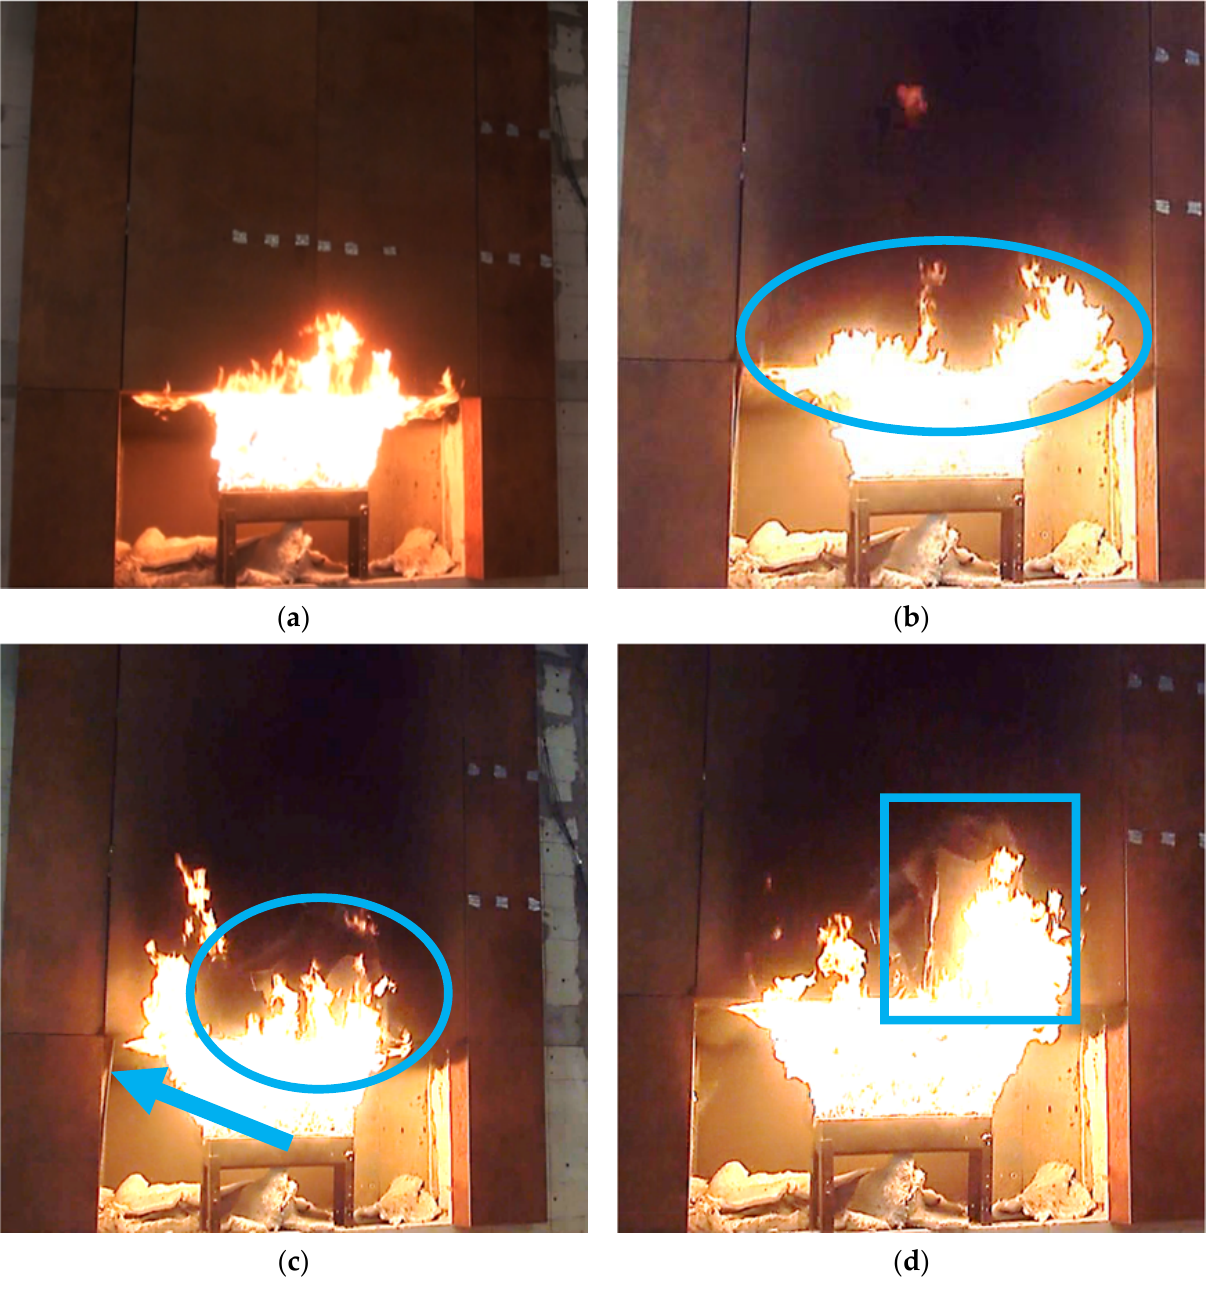
Figure 6. View of the large-scale facade model in successive minutes of the test: ( a ) start of the test; ( b ) approximately 11’00”—visible degradations; ( c ) approximately 17’00”—splay piece falling off; ( d ) approximately 20’30”—progress of destruction.